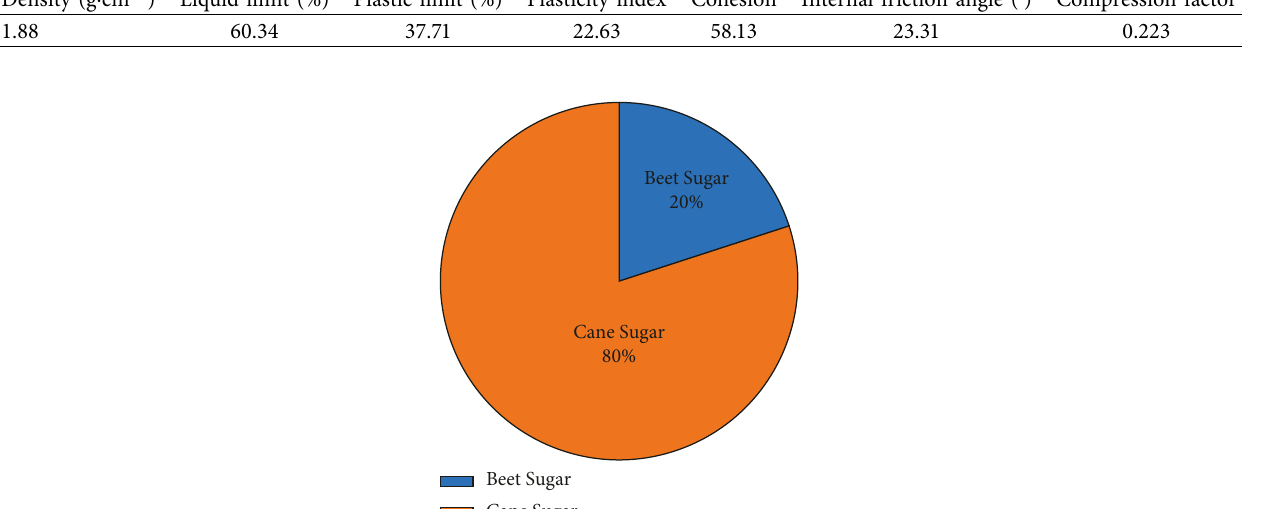
Figure 1: Composition of global sugar raw materials.